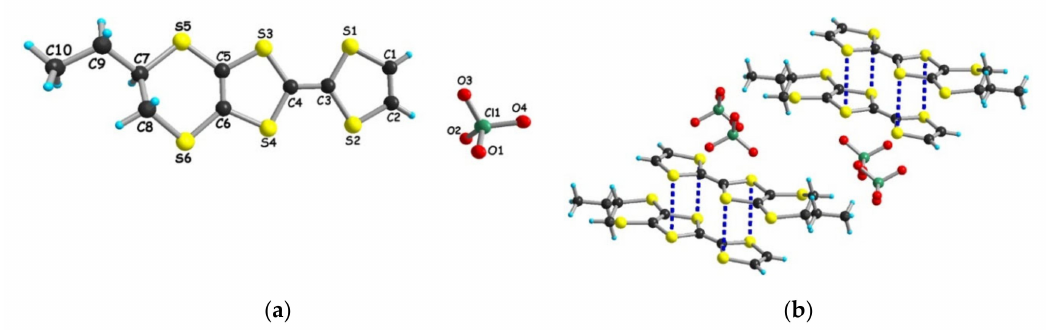
Figure 4. ( a ) Molecular structure of [( rac )- 2 ]ClO 4 along with the atom numbering scheme. Only the ( R ) enantiomer of the donor is shown; ( b ) Packing diagram of [( rac )- 2 ]ClO 4 , with an emphasis on the intradimer S ··· S short contacts (3.37 and 3.47 Å, blue dotted